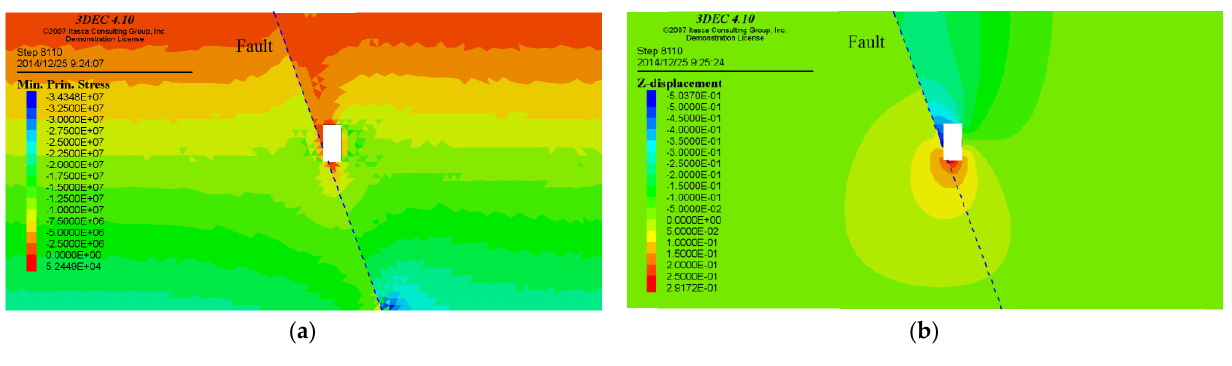
Figure 3. Nephogram of stress and displacement distribution of surrounding rock when the mining area is 0 m away from the fault (the fault cuts into the goaf), they should be listed as: ( a ) Maximum principal stress nephogram; ( b ) Vertical displacement nephogram.